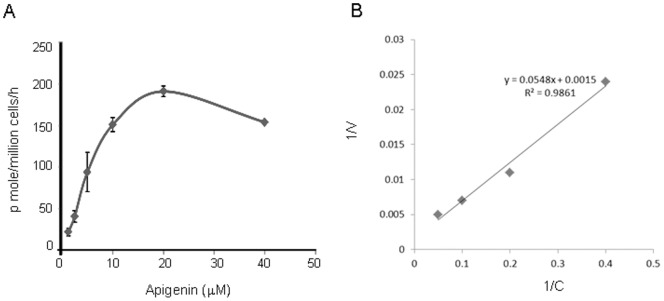
Kinetics of apigenin uptake by human prostate cancer LNCaP cells.(A) Dose-dependent kinetics of apigenin uptake in LNCaP cells incubated for 6 h with apigenin at concentration ranging from 1.25 µM to 40 µM. The rate of apigenin uptake was measured as (cellular apigenin) million cells−1 h−1. Points±SD of experiments performed three times. (B) Data evaluated using Michaelis-Menten kinetics by constructing a reciprocal plot between 1/C and 1/V. Details are described in materials and methods section.